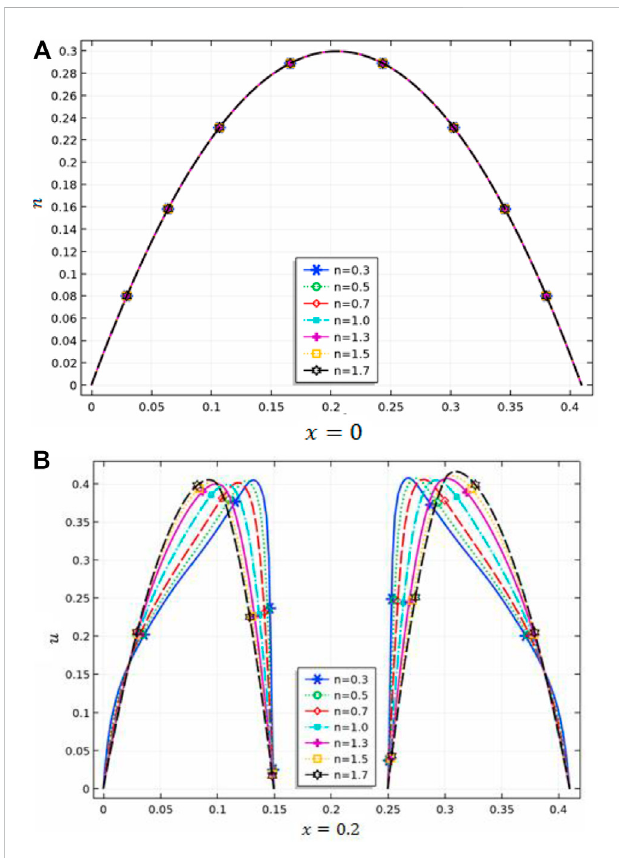
FIGURE 10 Horizontal velocity along a vertical line at various places on the x-axis for different values of n.